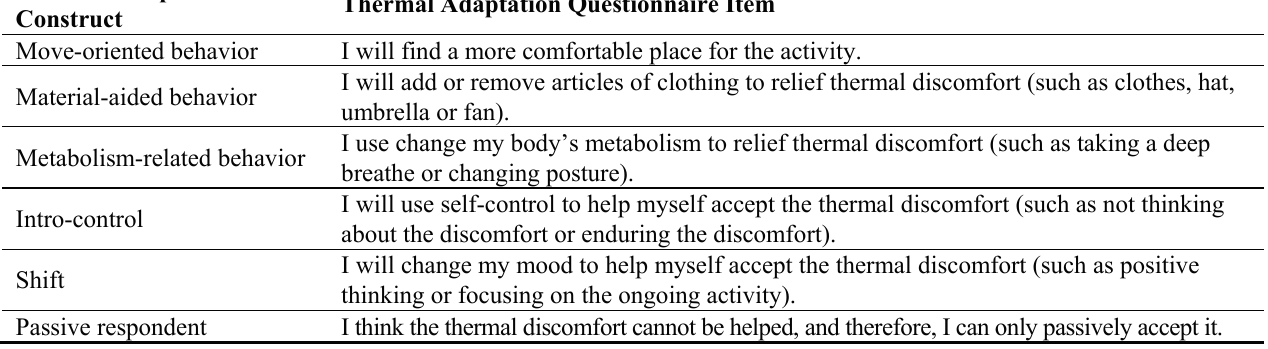
Table 2. Thermal adaption questionnaire items for urban plaza users in hot and humid Asia (simplified